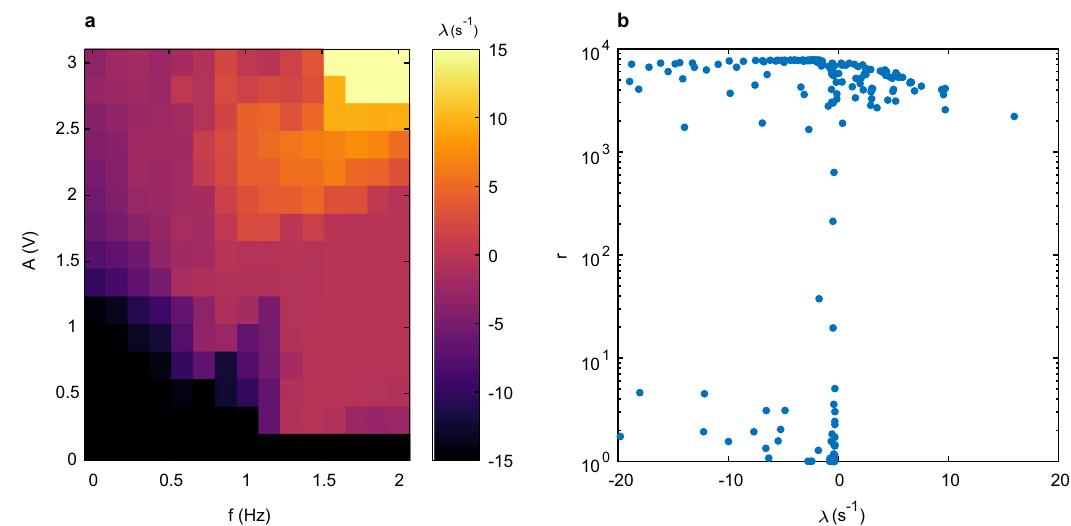
Fig. 6 Controlling network dynamical states with triangular AC signals. a For a 100 nanowire, 261 junction simulated network, the driving amplitude A and frequency f controls the maximal Lyapunov exponent λ and hence, dynamical evolution of the network: λ < 0 indicates convergence to stable attractor states; λ > 0 indicates chaotic dynamics; and λ ≈ 0 corresponds to an edge-of-chaos state. b For a given λ , the collective network response is captured by the average ratio of maximum-to-minimum network conductance states, r